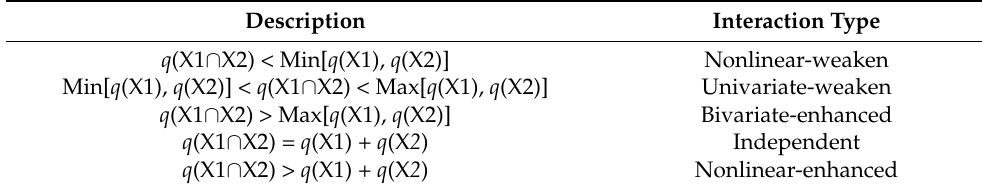
Table 1. Types of interaction between independent